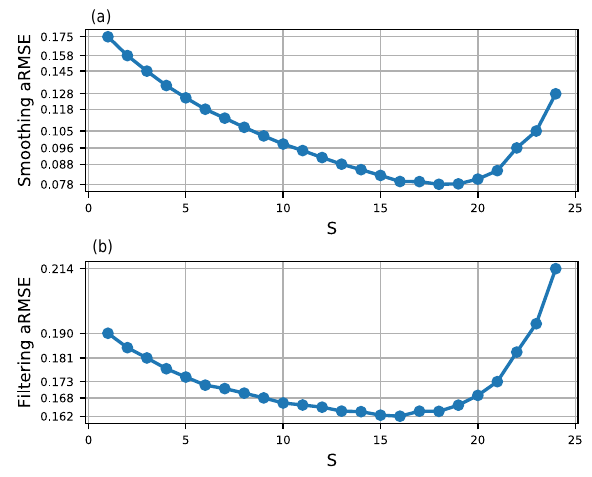
Figure 6. Smoothing aRMSE (a) and filtering aRMSE (b) of a Gauss–Newton IEnKS L = S as a function of S with the L95 model over 5 × 10 5 cycles (logarithmic scale). We used the finite-size ver- sion (Bocquet, 2011) to account for sampling errors and avoid the need for inflation, H = R = B = I m , n =